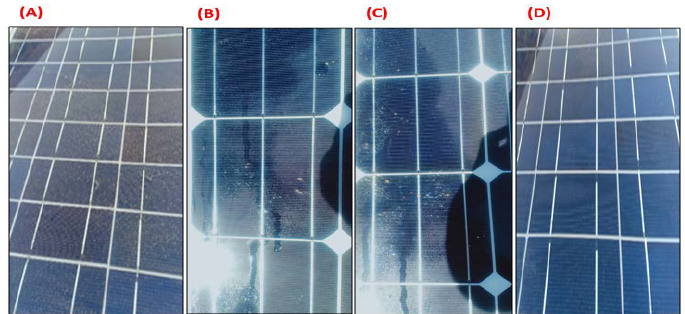
Figure 7. Process of surface self-cleaning with nano-coated material; starting from ( A ) dirty panel throughout ( B ) partially cleaned panel, then ( C ) almost cleaned panel, and finally ( D ) totally cleaned panel.